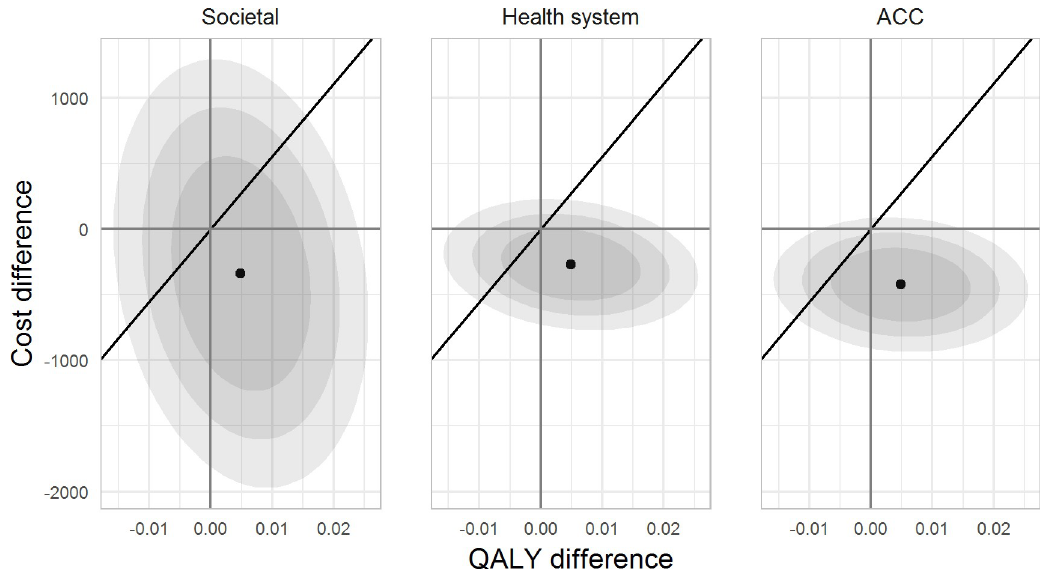
Fig 5. Cost-effectiveness plane. Shaded areas show 50% (darker), 75%, and 90% (lighter) confidence ellipses. Solid line shows WTP threshold at 1 × GDP per capita; areas below and to the right of the line indicate the intervention is cost-effective relative to control; above and to the left indicate the intervention is not cost-effective. ACC, Accident Compensation Corporation; GDP, gross domestic product; QALY, quality-adjusted life year; WTP, willingness to pay.